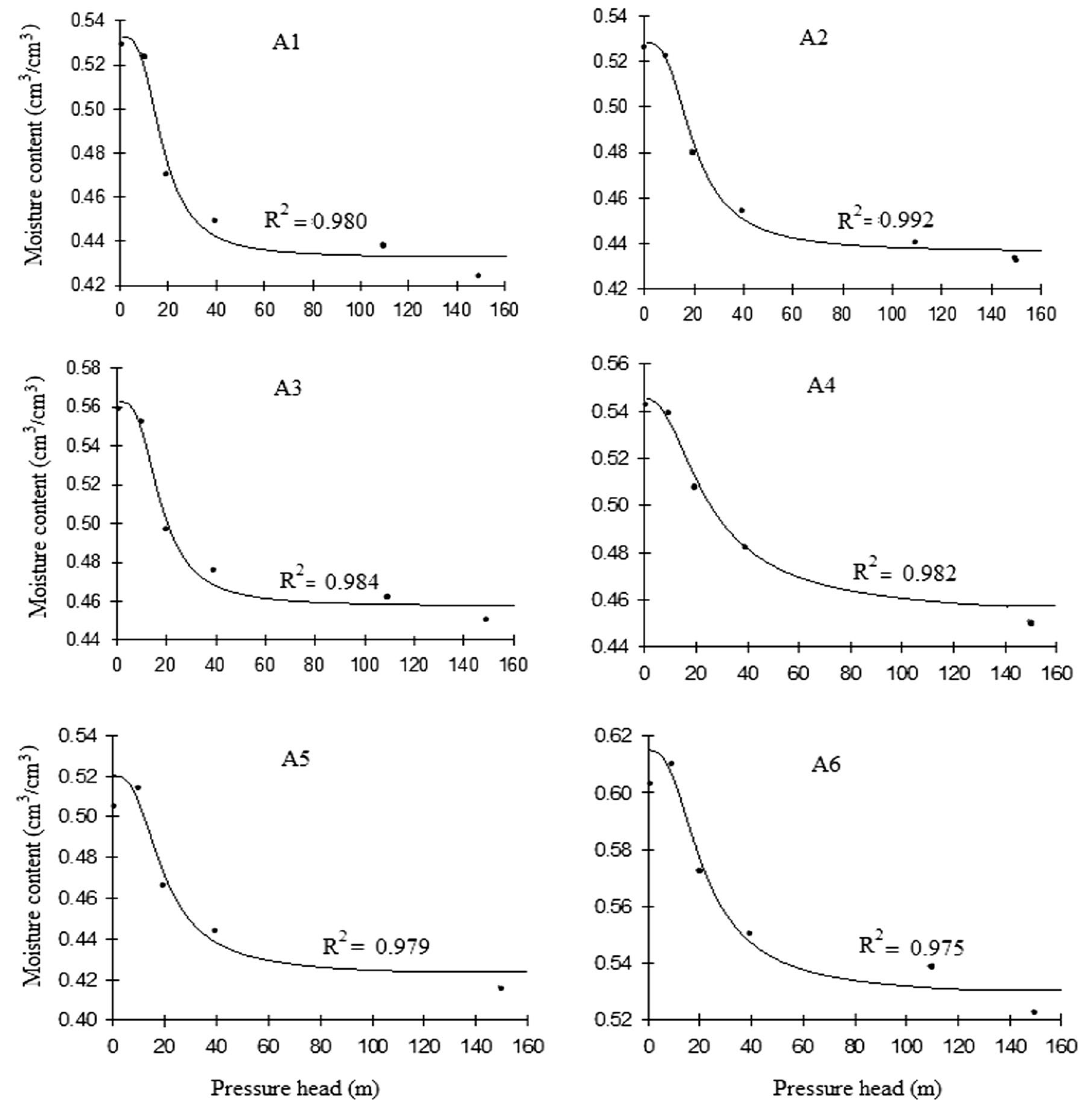
Fig. 3 Soil water retention characteristic curves, fitted using the RETC program, based on the van Genuchten (1980) soil water retention model (black shaded circle Laboratory measured,solid line Fitted)